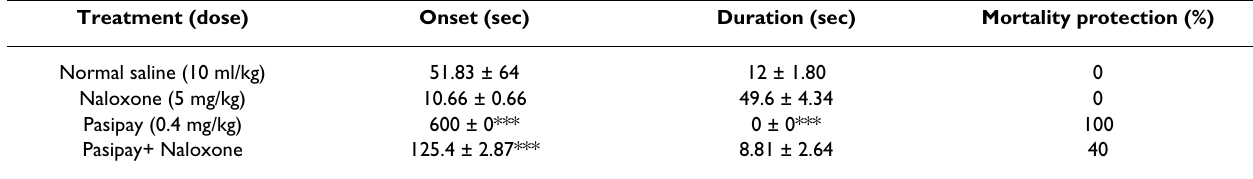
Table 3: Effect of naloxone on the anticonvulsant activity of Pasipay in PTZ-induced convulsion in mice Treatment (dose)